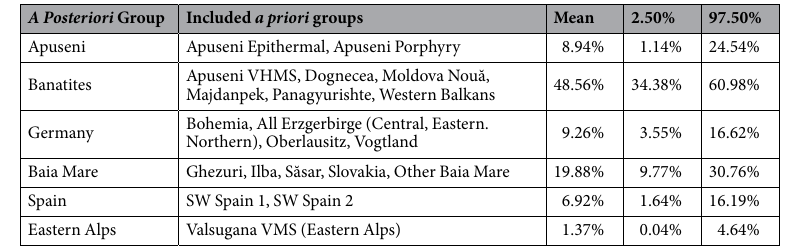
Table 6. A posteriori grouping of raw MixSIAR results as displayed in Table 5, from the Romanian litharge